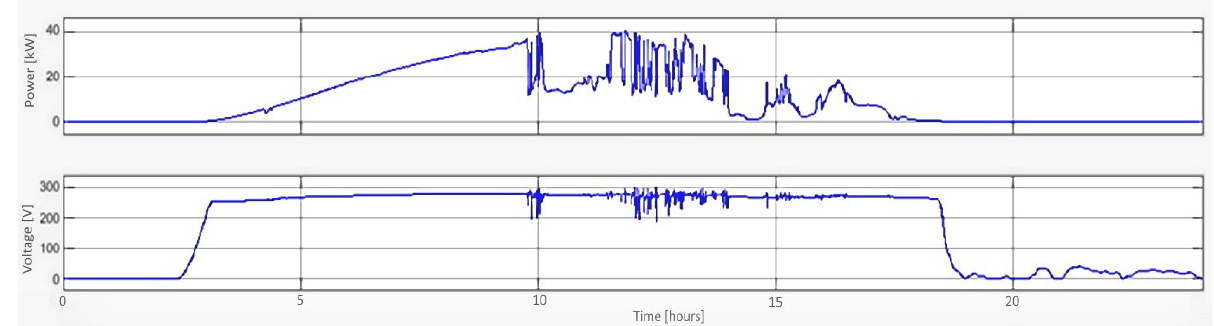
Figure 19. Daily waveform of power generated by the modules and the average voltage at the output of the PV modules (39.65 kW) on a sample day in July.